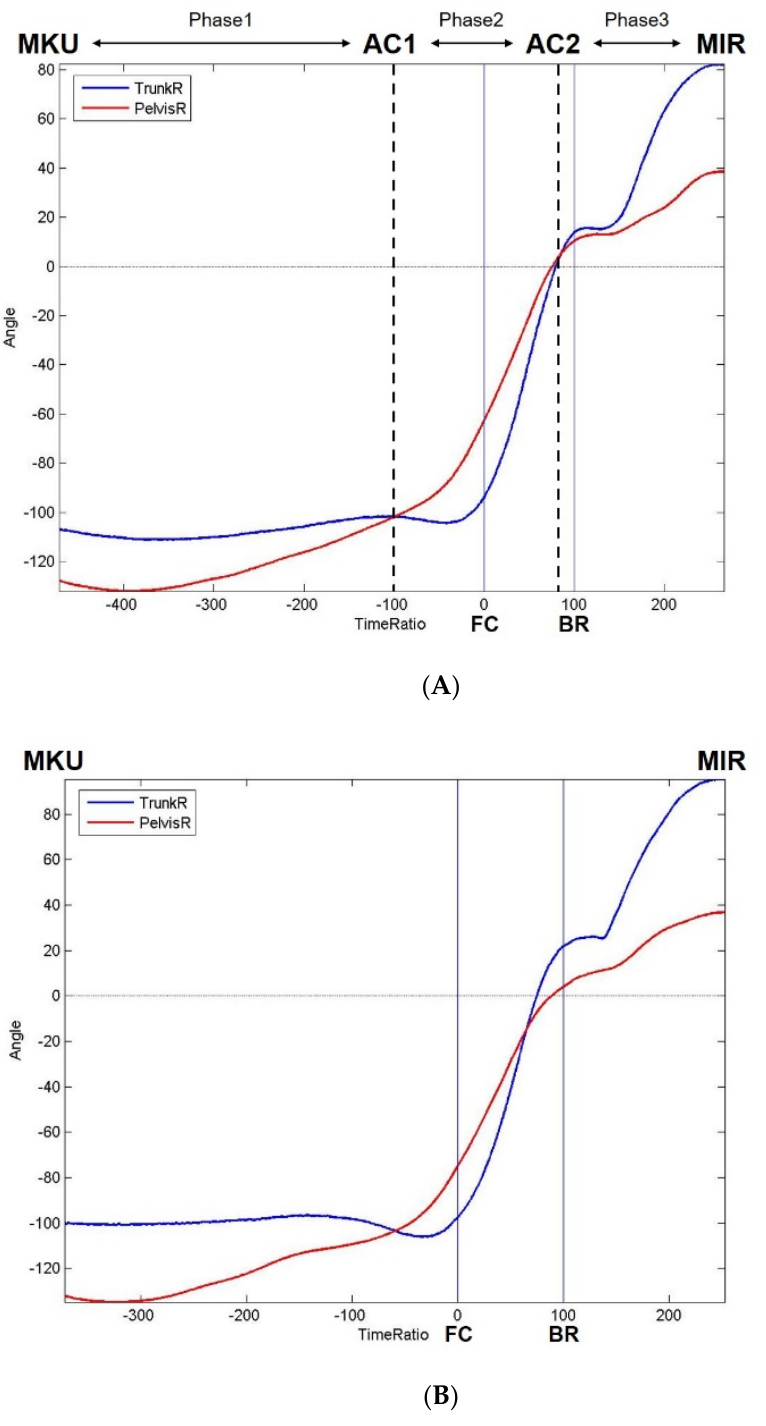
Figure 3. ( A ) Curves of mean rotational angle of pelvis and trunk related to time ratio from MKU to MIR of Pattern1. It shows two special time events: AC1 and AC2, as well as three novel phases. ( B ) Curves of mean rotational angle of pelvis and trunk related to time ratio from MKU to MIR of Pattern2. AC1 = time of first pelvic and trunk angle crossing; AC2 = time of second pelvic and trunk angle crossing; BR = ball-release; FC = foot contact; MIR = maximum -shoulder-internal-rotation; MKU = maximum-knee-up.